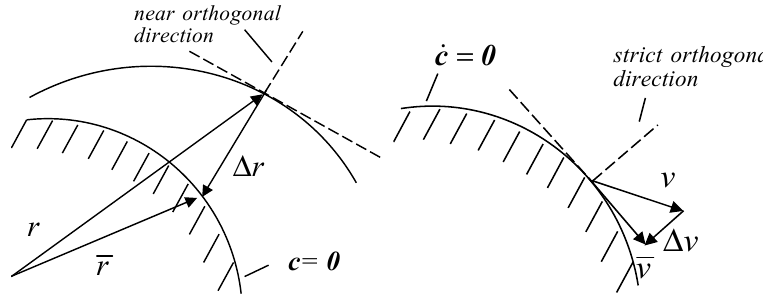
Figure 1. Sketch of the coordinate projection method.